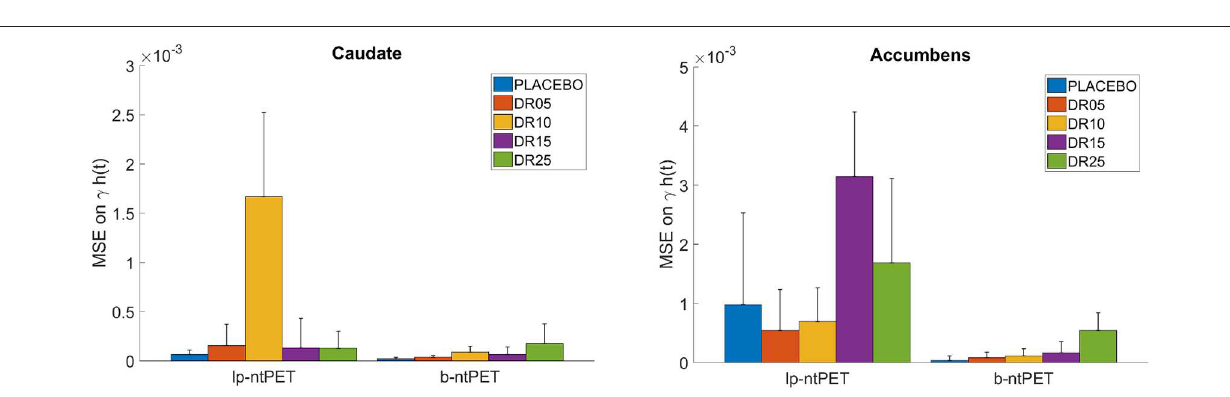
consequently a significant difference was detected between groups ( p <